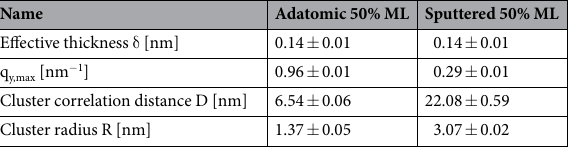
Table 1. Calculated structural values for soft-landed adatomic and sputtered